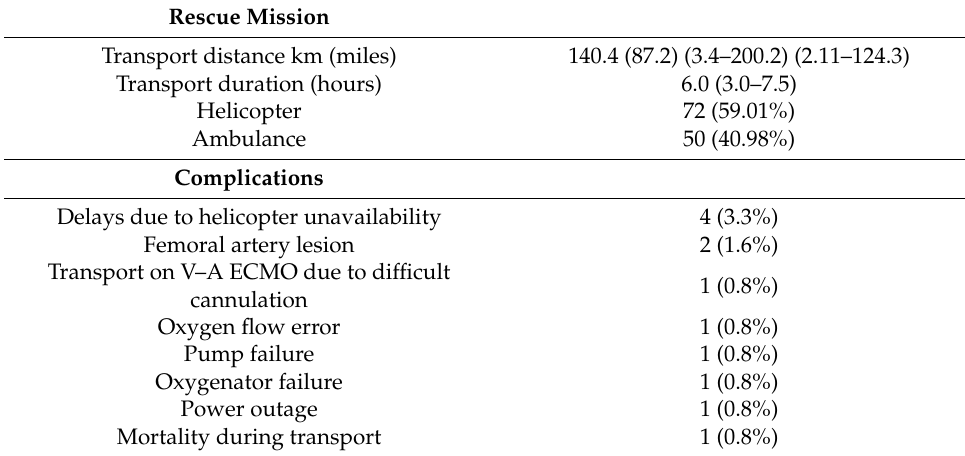
Table 2. Rescue mission characteristics and complications.